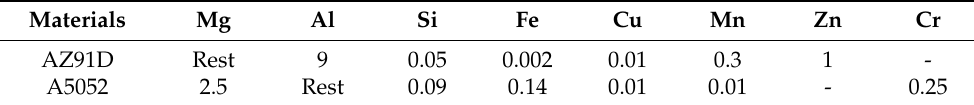
Table 1. Chemical compositions of the AZ91D and A5052 alloys [mass%].